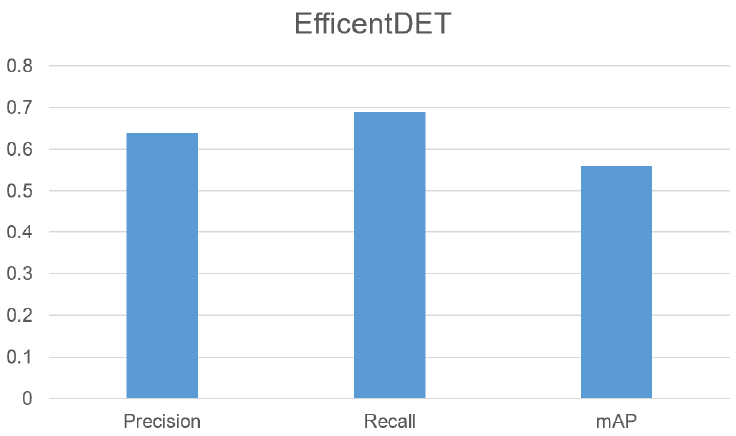
Figure 17. EfficentDET comparison graph.